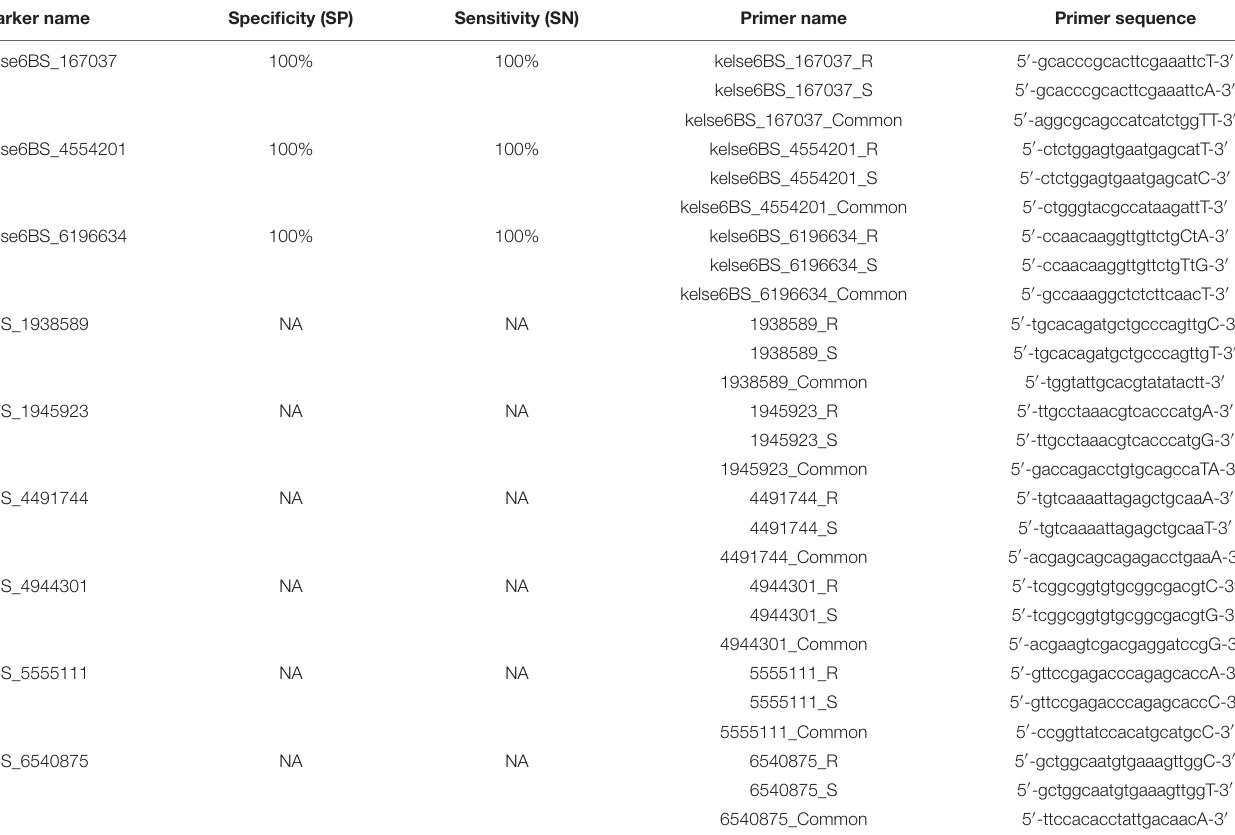
TABLE 1 | Kompetitive Allele Specific PCR (KASP) markers tightly linked to the resistance loci on short arm of chromosome